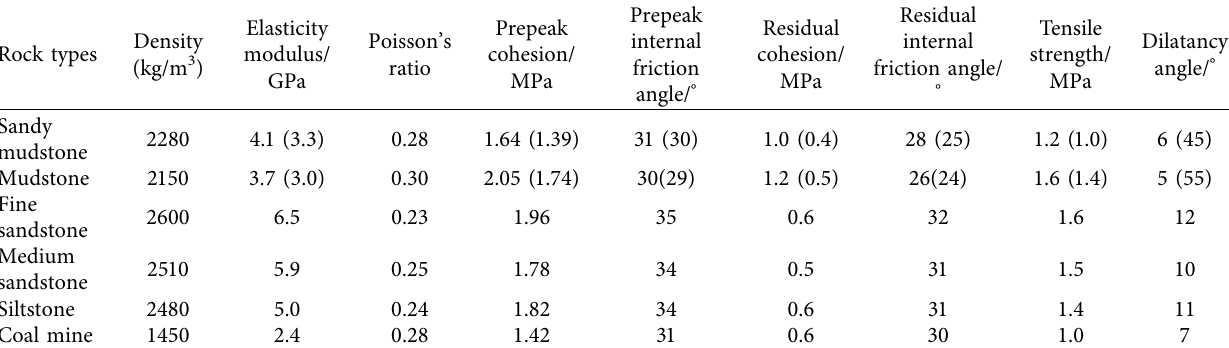
Table 1: Mechanical parameters of surrounding rock of roadway.